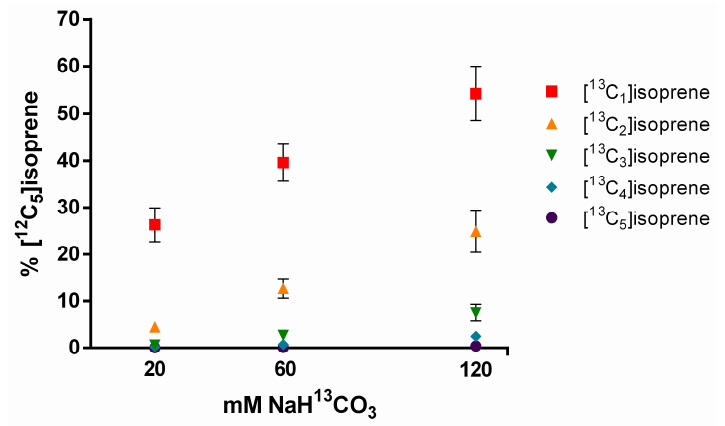
Figure 7. Percentage of 13 C-labeled isoprene emissions ( 13 C 1-5 ) relative to unlabeled isoprene emissions ( 12 C 5 ) from detached I. edulis leaves fed with three concentrations of NaH 13 CO 3 solutions (20, 60, and 120 mM) through the transpiration stream; means and standard deviation for n = 5. When leaflets were placed in the 20 mM solution of sodium bicarbonate 13 C they emitted Is with one labeled carbon, representing 26% of the emissions of unlabeled isoprene molecules. Emissions of molarity (20–120 mM), the percentage of Is with 13 C-labeling also increased relative to the unlabeled Is , as did the number of carbon atoms 13 C-labeled per molecule. In the solution with 120 mM of sodium bicarbonate 13 C, the percentage of molecules with one 13 C atom reached 54%, with two labeled carbons 25%, with three labeled carbons 8%, with four labeled carbons 2%, and with all labeled carbons reaching up 0.35% (relative to unlabeled Is ). 4. Discussion 4.1. Under CO 2 -Free Air, Isoprene Emissions Display a Similar Light and Temperature Response Pattern to That under Ambient Conditions, But Is Eliminated when Photosynthesis Is Inhibited The high correlation between Is and Pn as a function of light (Figure 1) is widely discussed in literature, since isoprene production via the MEP pathway utilizes, as the first precursor, a product of the Calvin–Benson cycle, glyceraldehydes-3-phosphate (G3P), which is responsible for three of the five carbons in the isoprene skeleton and requires 14 mol of NADPH and 20 mol of ATP for each mole of isoprene synthesized [37–42] (Figure 8). Thus, it is expected that the relationship between Pn and Is be close under ambient CO 2 conditions (Figure 1b). The production of isoprene from the tropical species I. edulis under a CO 2 -free atmosphere in this study is consistent with previous research on several temperate plant species including myrtle ( Myrtus communis ), buckthorn ( Rhamnus alaternus ), velvet bean ( Mucuna pruriens ), gray poplar ( Populus x canescens ), aspen ( Populus tremuloides ), and tasmanian bluegum ( Eucalyptus globulus ) [16,27,32,43]. We demonstrate for the first time that Is from I. edulis under CO 2 -free air are stimulated by light and temperature in a similar fashion to emissions under ambient CO 2 , albeit with important differences (Figure 2b and Figure 5b). Relative to emissions under ambient CO 2 , Is under a CO 2 -free atmosphere were reduced and saturated at low light levels (e.g., 100 mol m −2 s −1 PPFD) versus no clear light saturation under ambient CO 2 up to 2000 mol m −2 s −1 PPFD. Other studies that observed Is under limited or zero CO 2 have suggested that alternative carbon sources, that do not come directly from photosynthesis, such as stored starch and carbohydrates transported in the xylem stream help to maintain the carbon supply for isoprene when a reduced atmospheric CO 2 source is